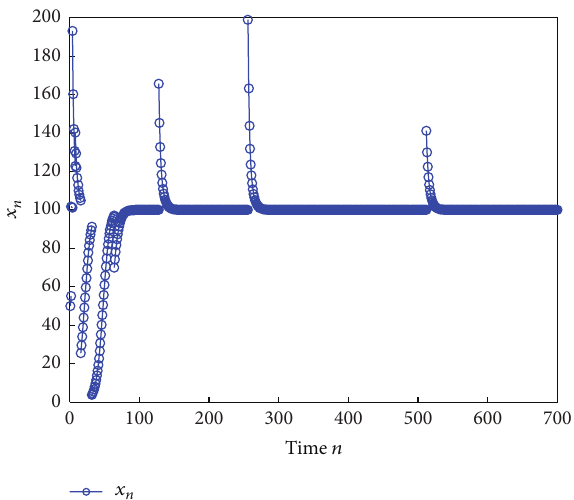
Figure 1: Permanence of system (1) with initial condition 𝑥 0 = 50 .